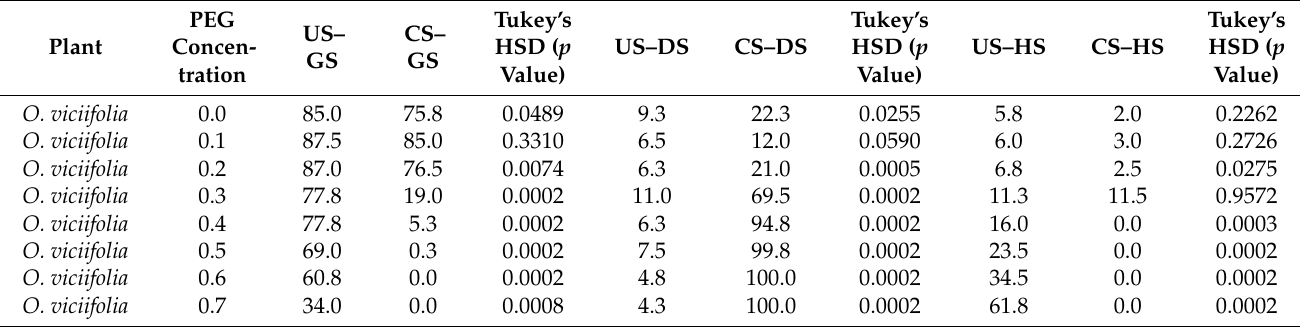
Table A9. Results of Tukey’s HSD test— O. viciifolia